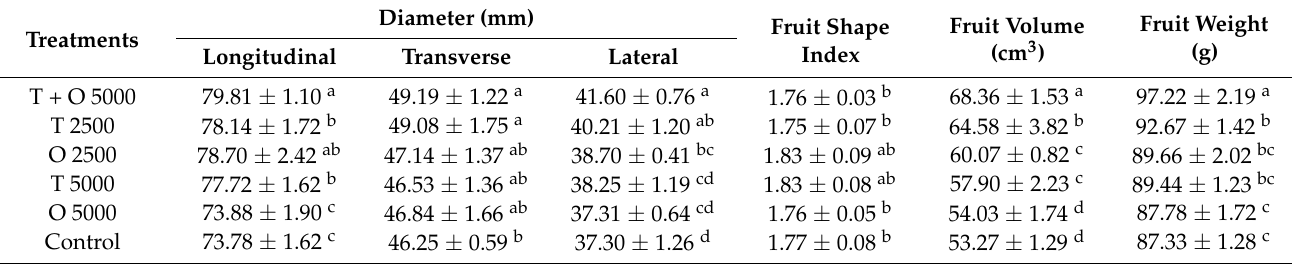
Table 5. The effects of tebuconazole and oligosaccharins on kiwifruit’s development.